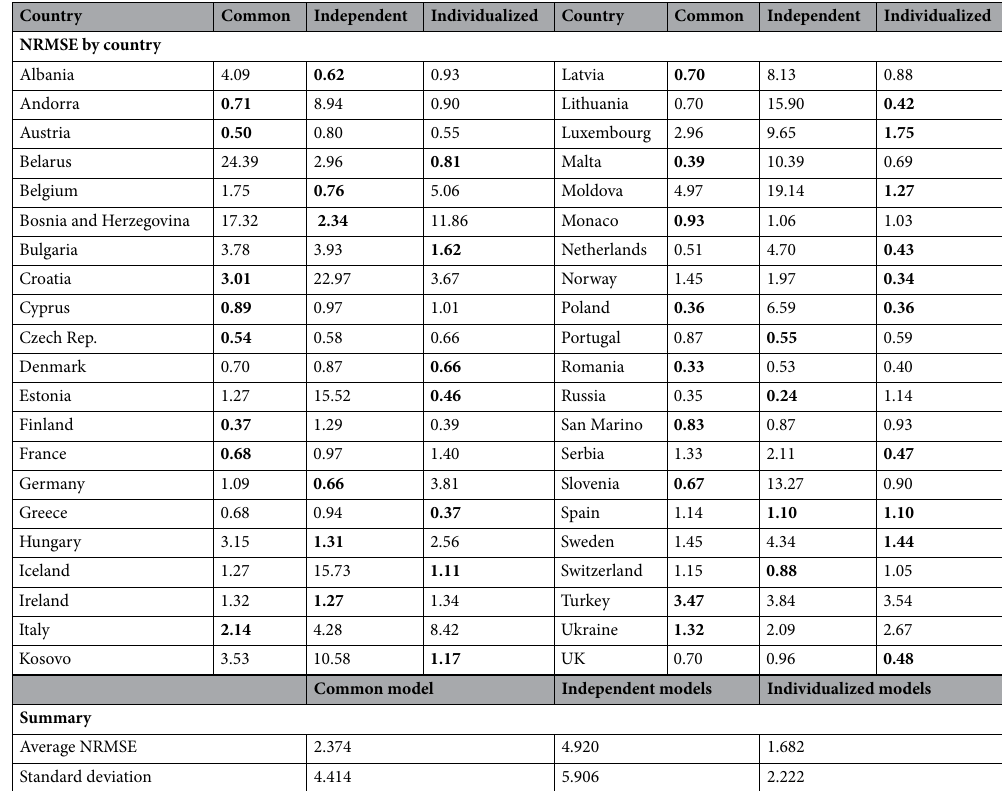
Table 4. Performances of the final models (with optimized values of coefficients k EI = 0.2605 and k IR = 0.1020 ). For each country, lowest error values are in bold. Average NRMSE and standard deviation for each approach is also